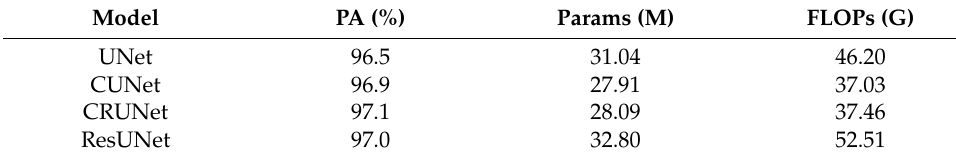
Figure 7. Convergence performance of the CRUNet architecture. Starting from a baseline UNet, we add components keeping all training hyperparameters identical. Table 3. The efficiency comparison of the various methods.